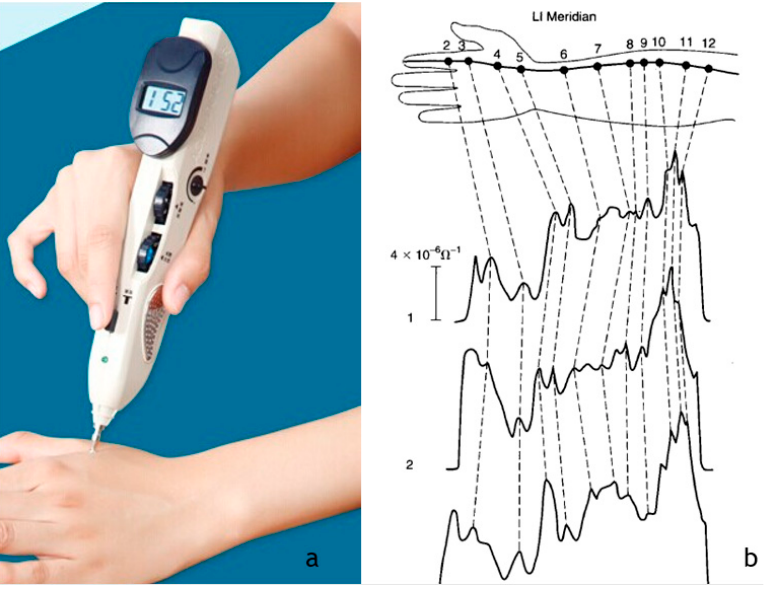
Figure 5. Acupoint detector device ( a ) [83] and three successive conductance scans along the Large Intestine Meridian–numbers in the upper limb correspond to acupoints ( b ) Reprinted with permission from ref. [62] Copyright 2002 Elsevier and Copyright Clearance